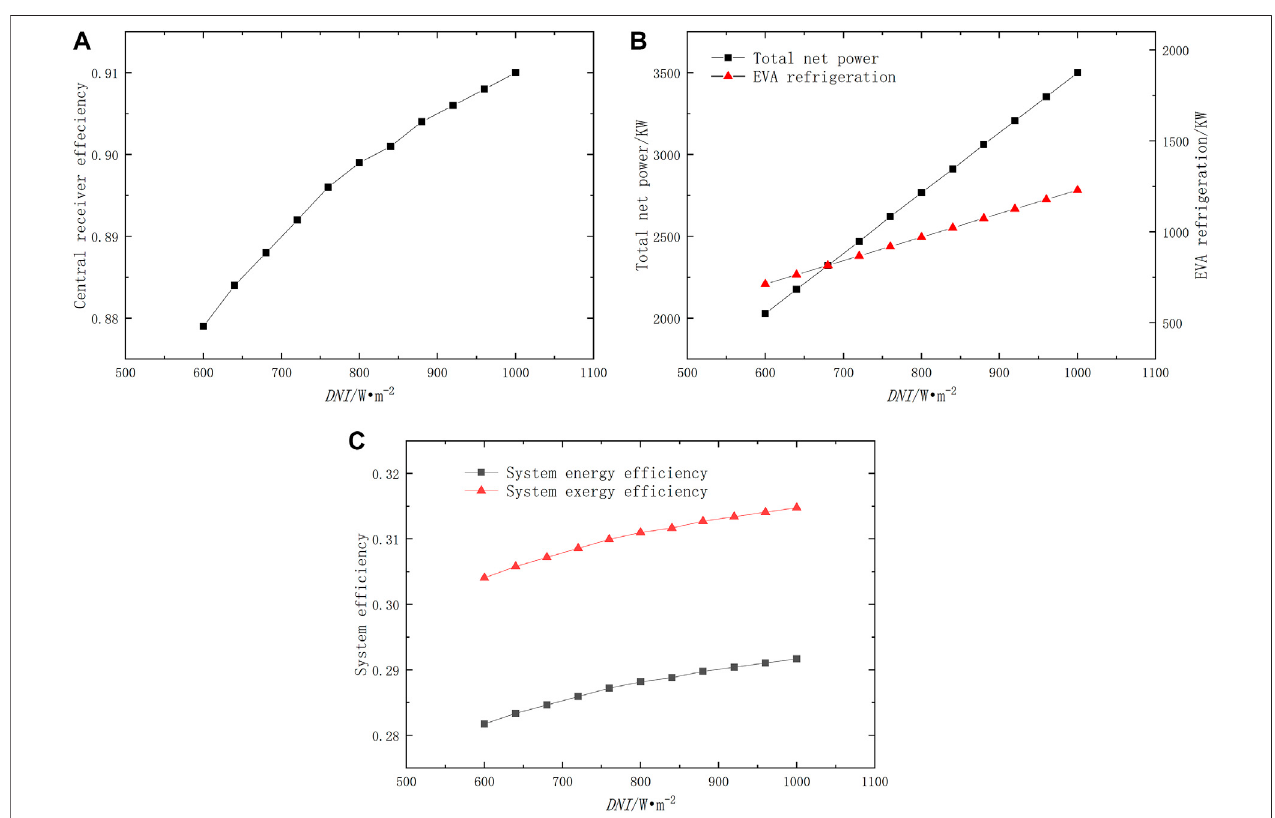
FIGURE 4 | Effect of direct normal irradiation DNI .